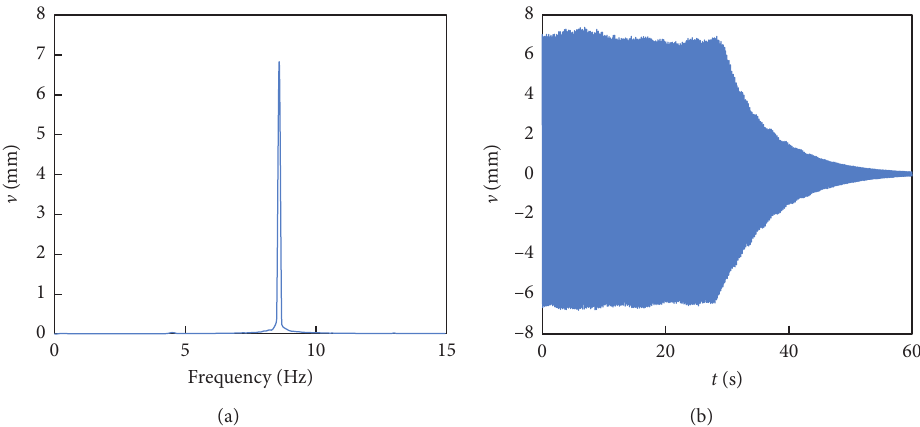
Figure 13: Galloping data obtained from the laser sensor at 1/4 cable length at U curves. (b) Time history.